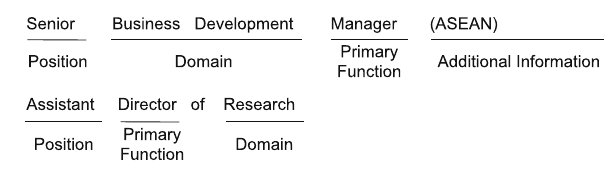
Fig. 3 Examples of parsed job